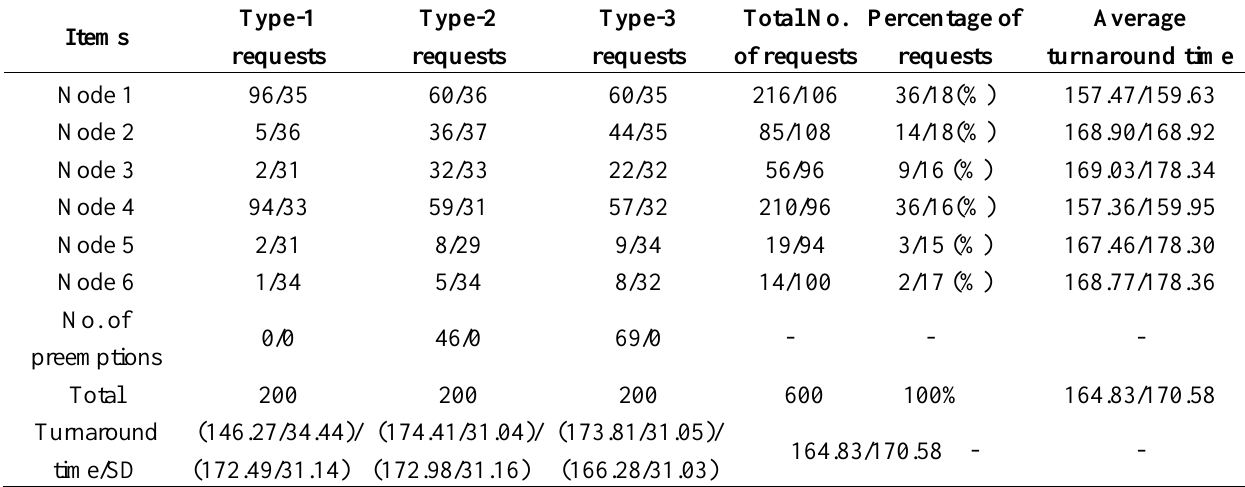
Table 14. The numbers of requests allocated and their turnaround times when 200 type- i requests were submitted, i = 1, 2, 3, and SPA-WP and Random algorithms were